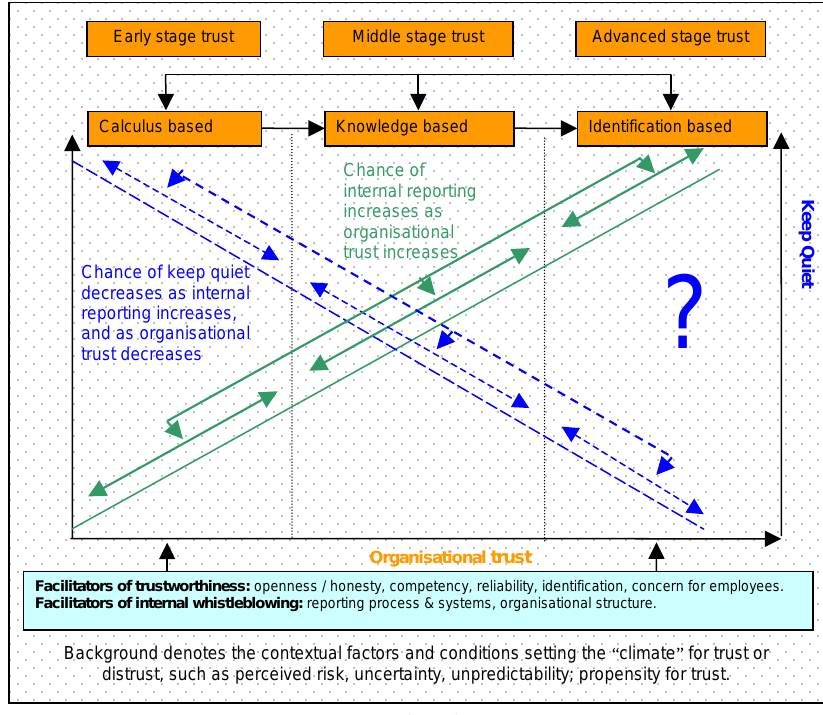
Figure 2 The relationship between organisational trust, internal whistleblowing and keeping